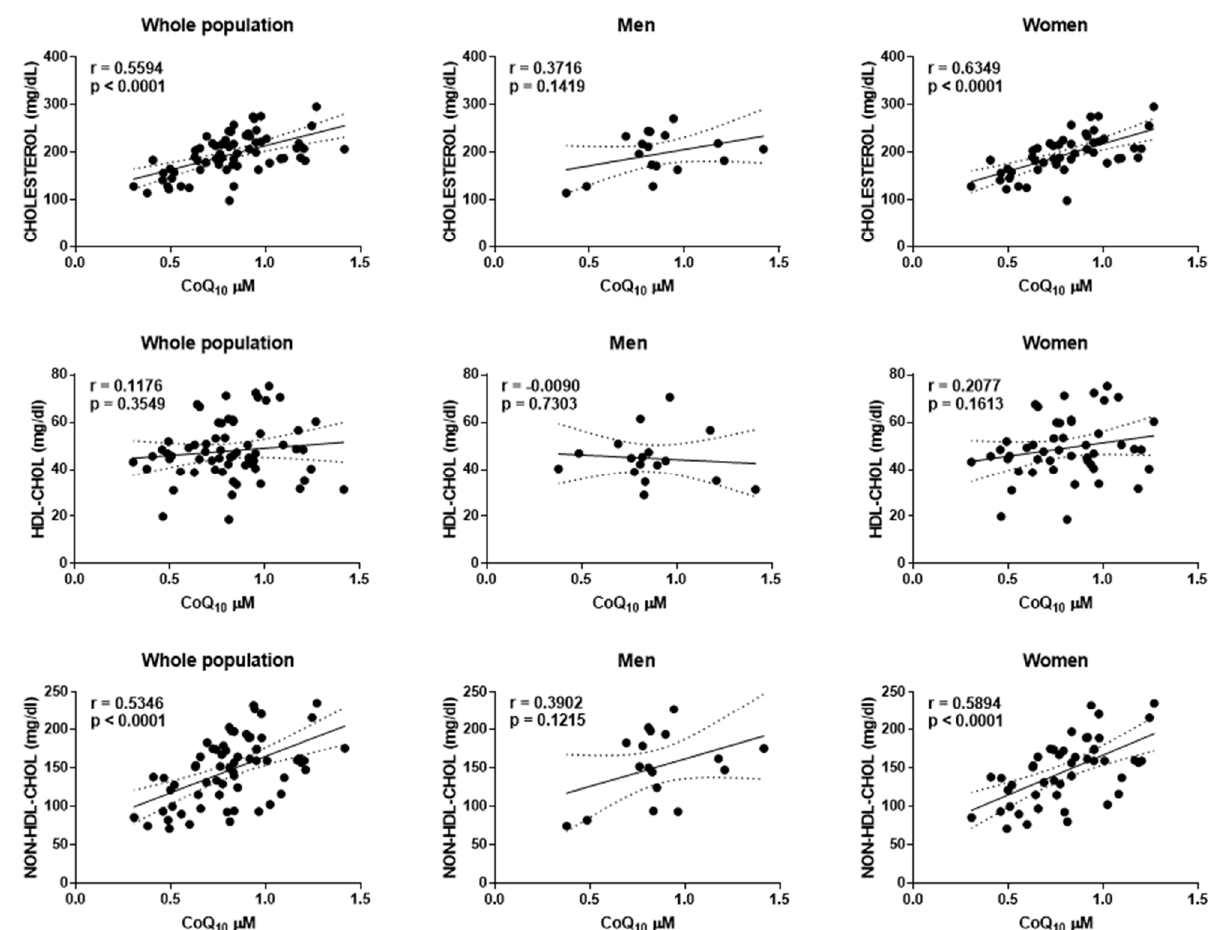
Figure 2. Correlation among plasma CoQ 10 levels ( μ M) and total cholesterol, HDL cholesterol and non-HDL cholesterol in plasma. Pearson’s r correlation (r) and statistical significance are indicated. Table 4. Correlation between CoQ 10 levels and blood plasma biochemical parameters.